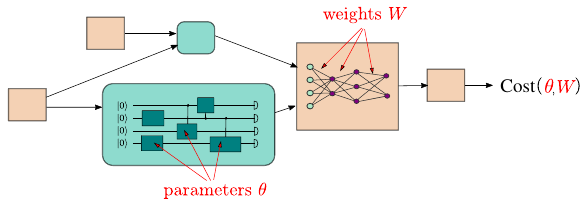
FIG. 3. Parametrized quantum circuits can be trained as parts of larger machine-learning pipelines by making use of automatic differentiation and the fact that we know in many settings how to estimate analytic gradients of cost functions with respect to circuit